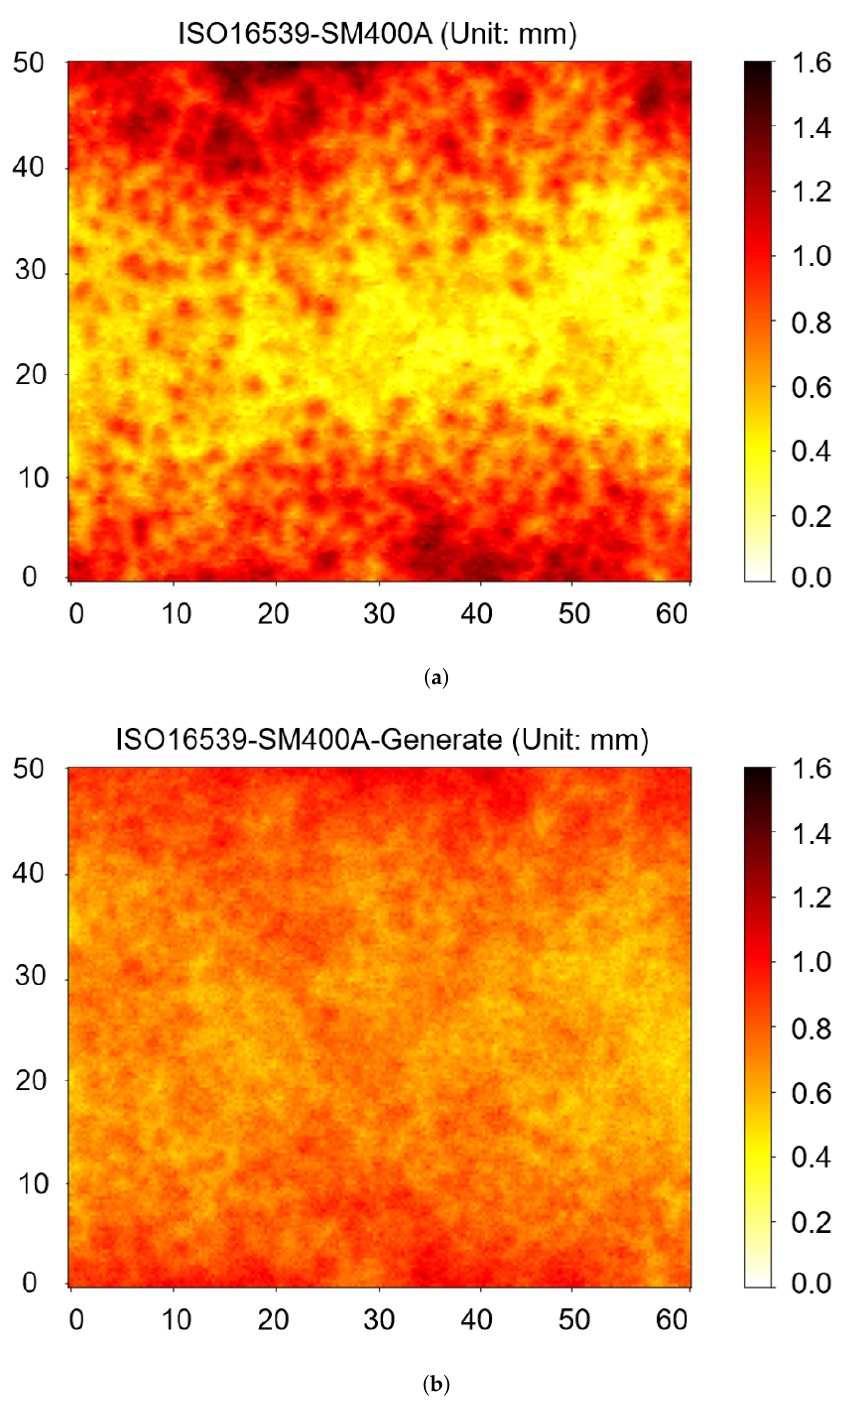
Figure 8. The Corrosion on ISO16539 Type SM400A Steel Plate Stage Three and Corresponding Simulated Corrosion. ( a ) The Corrosion on ISO16539 Type SM400A Steel Plate Stage Three; ( b ) The Corrosion on Simulated Type SM400A Steel Plate Stage